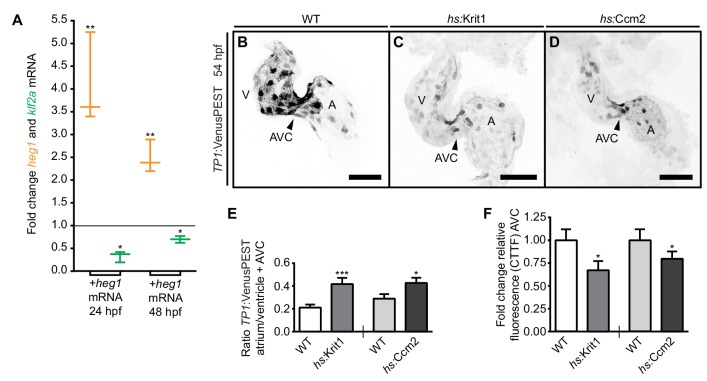
Desensitization of endocardial cells to blood-flow by heg1, krit1, or ccm2 overexpression.(A) Correlation of high heg1 and low klf2a mRNA expression levels at 24 and 48 hpf as determined by RT-qPCR. (B–D) Projections of confocal z-stack images of 54 hpf hearts expressing the flow-responsive marker Tg(TP1:VenusPEST)s940 in heat-shocked wild-type (WT) (B), heat-shock- (hs) induced krit1 overexpression (C), and hs-induced ccm2 overexpression (D). (E) Different ratios of corrected total tissue fluorescence (CTTF) of atrial versus ventricular (+atrioventricular canal region (AVC), arrowhead) expression of the flow-responsive marker Tg(TP1:VenusPEST)s940 between 54 hpf WT and krit1-overexpressing hearts (n = 37) and WT and ccm2-overexpressing hearts (n = 39). krit1- or ccm2-overexpression results in more equal chamber expression of flow-responsive marker Tg(TP1:VenusPEST)s940 expression (depicted is a WT heart corresponding to the krit1-overexpression experiment). (F) Fold change of relative fluorescence (CTTF) in the AVC of Tg(TP1:VenusPEST)s940 in krit1- and ccm2- overexpressing hearts versus the corresponding controls. Scale bars are 50 µm. Mean values ± SEM are shown. Unpaired t-test was used to compare each condition with the WT (*p<0.05, **p<0.01, ***p<0.001).